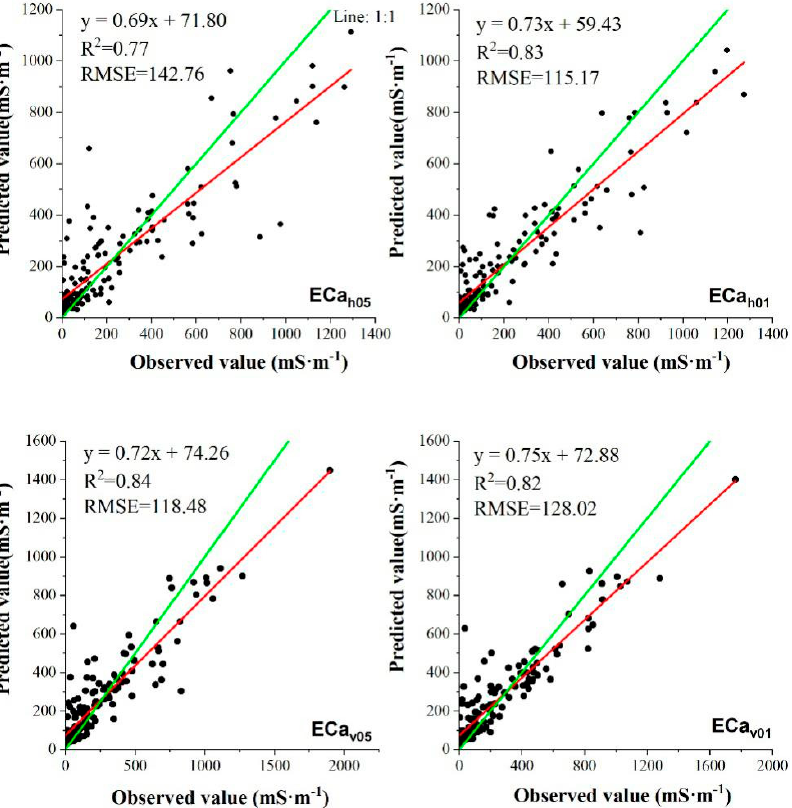
Figure 6. Scatter plots of measured vs predicted values for validation model using four EMI coil configurations with 1:1 (green) and overall trend (red) lines.